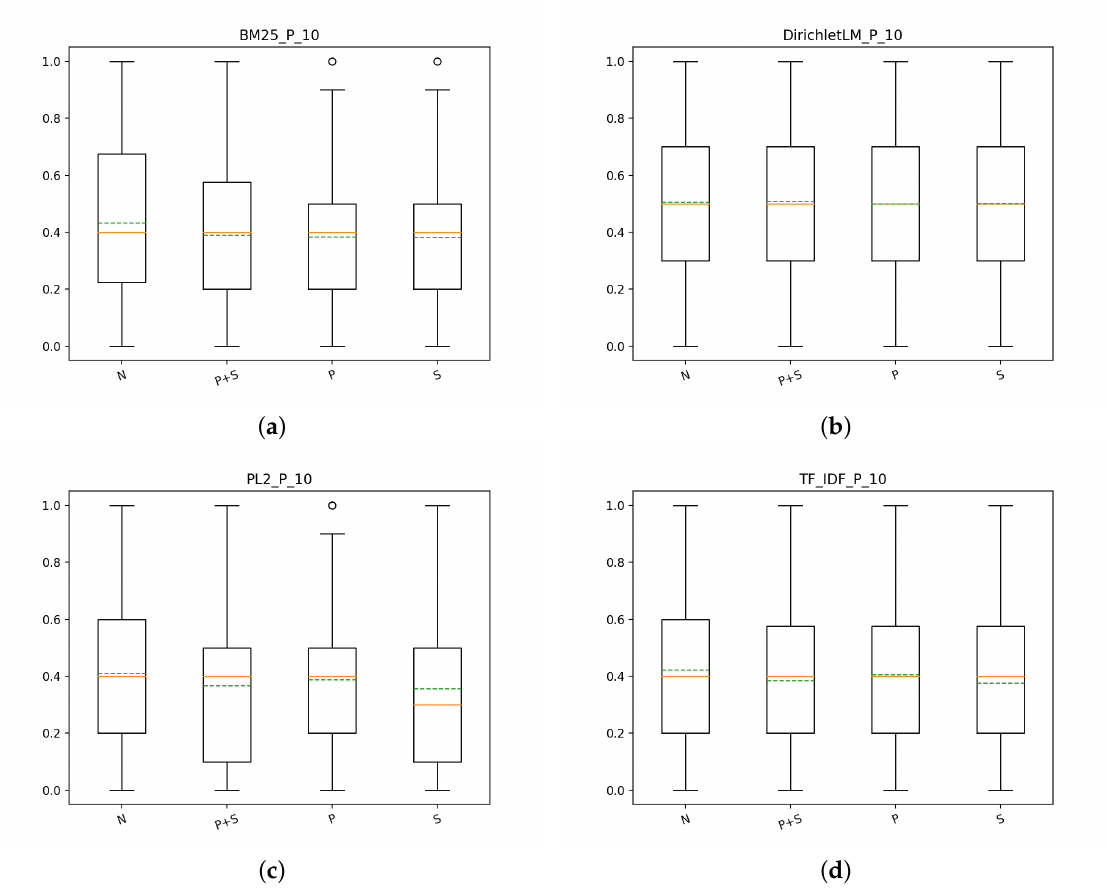
Figure 11. T2: box plots for P@10 of the different indexes for each model, with QE+RF: ( a ) precision for BM25 with different indexes, ( b ) precision for DirichletLM with different indexes, ( c ) precision for PL2 with different indexes, ( d ) precision for TF-IDF with different